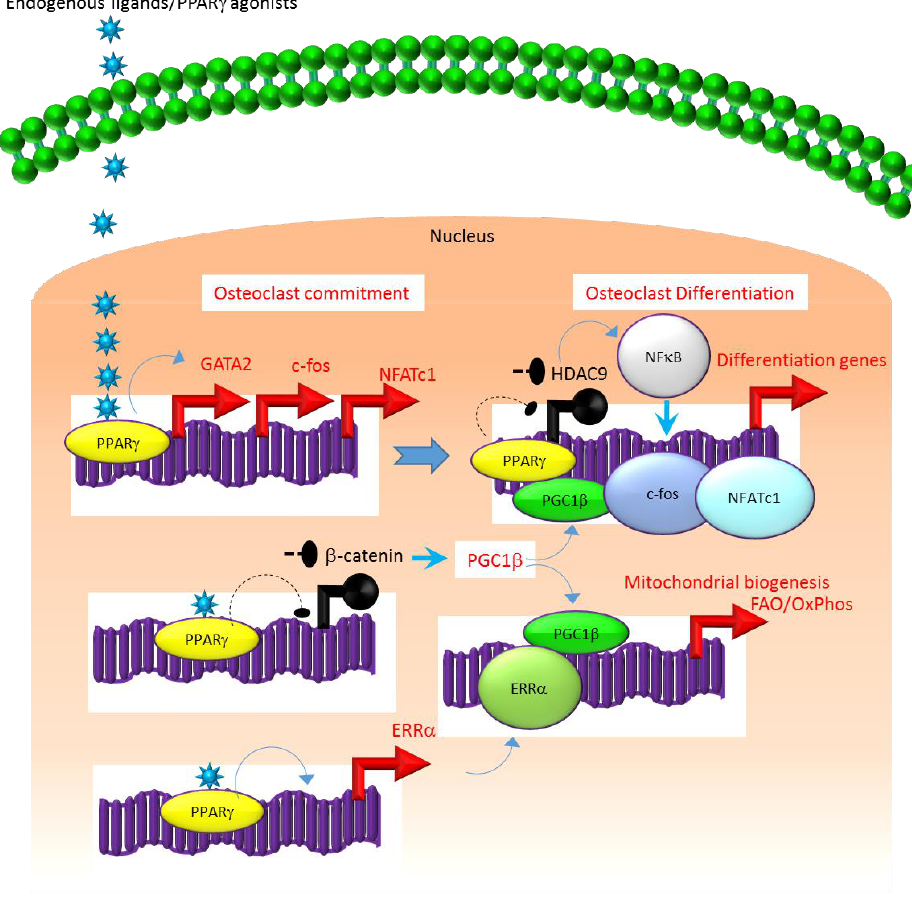
Figure 1. Regulation of osteoclastogenesis by PPAR γ . Adipogenic stimulus prevailing in bone marrow can induce osteoclastogenesis by activating PPAR γ that in turn activates the transcription of target genes such as GATA2, c-fos, NFATC1 and ERR1 α that induce osteoclast di ff erentiation in HSCs. Additionally, suppression of Wnt / β -catenin signaling by PPAR γ can induce PGC1 β which can function as a transcriptional co-activator for ERR1 α to promote the induction of mitochondrial fatty acid β -oxidation and oxidative phosphorylation genes that are critical for inducing mitochondrial biogenesis to support osteoclast function. PGC1 β also can serve as a transcriptional co-activator for PPAR γ to induce target genes that stimulate osteoclast di ff erentiation. Blue colored arrow-ended lines: stimulation / activation; Black circle-ended dash lines: inhibition. Red colored pointed arrows: transcriptional activation; Black colored closed circles: transcriptional repression.